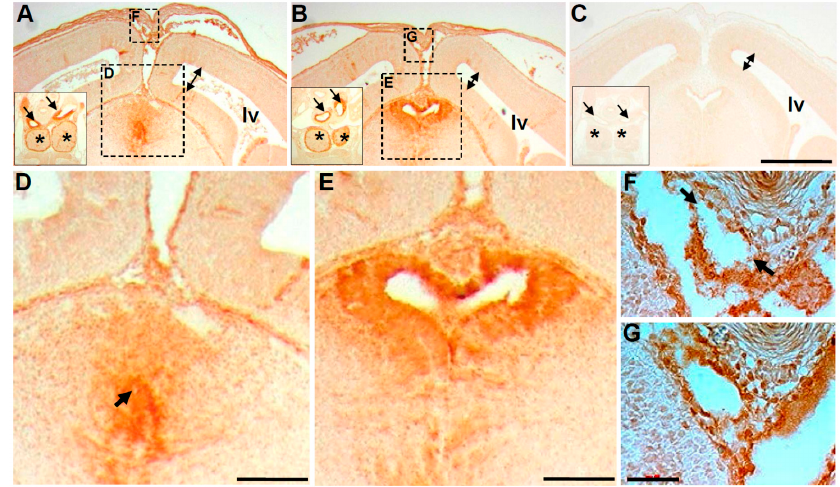
brain third ventricle. ( A – E ) Coronal sections of E14.5 of Pax3 flox { flox /Wnt1-Cre; R26r mutant ( A , D ), Wnt1-Cre/R26r control ( B , E ) and Pax3 flox { flox /R26r control ( C ) littermates following β -galactosidase (brown) immunohistochemistry to unequivocally detect lacZ expression. The Wnt1-Cre -negative sample ( C ) serves as a negative control. Significantly, the epithelium lining the control third ventricle and subcommissural organ is specifically labeled ( B ), whereas in the mutant ( A ), although a group of cells is positively labeled, they failed to form a normal tubular structure in the mutant. Enlarged views from A , B (indicated via large dotted line boxed areas labeled D , E ) reveal lacZ -expressing elongated columnar epithelial cells surrounding a clear opening in control ( E ) but lacZ -expressing mutant cells fail to establish the normal opening to the third ventricle (arrow in D ). Additionally, double-headed arrows indicate the space in the lateral ventricles in all three genotypes, revealing a mild dilation of lateral ventricles in only the mutant ( A ). Inserts in A , B (solid line boxes) show a similar pattern of typical Wnt1-Cre/R26r expressing cells in both mutant and control great arteries (arrows) and thymus (asterisk), from more posterior sections adjacent to the outflow tract of the heart. ( F , G ) High-power view from small dotted line boxed areas in A , B , demonstrating that the superior sagittal sinus (SSS) and surrounding tissue are positively labeled for Wnt1-Cre/R26r lineage. Note however that the circumferential labeling pattern seen in control ( G ) is discontinuous in the mutant (arrows, F ). Scale bars: A–C = 400 µ m; D,E = 130 µ m; F,G = 50 µ